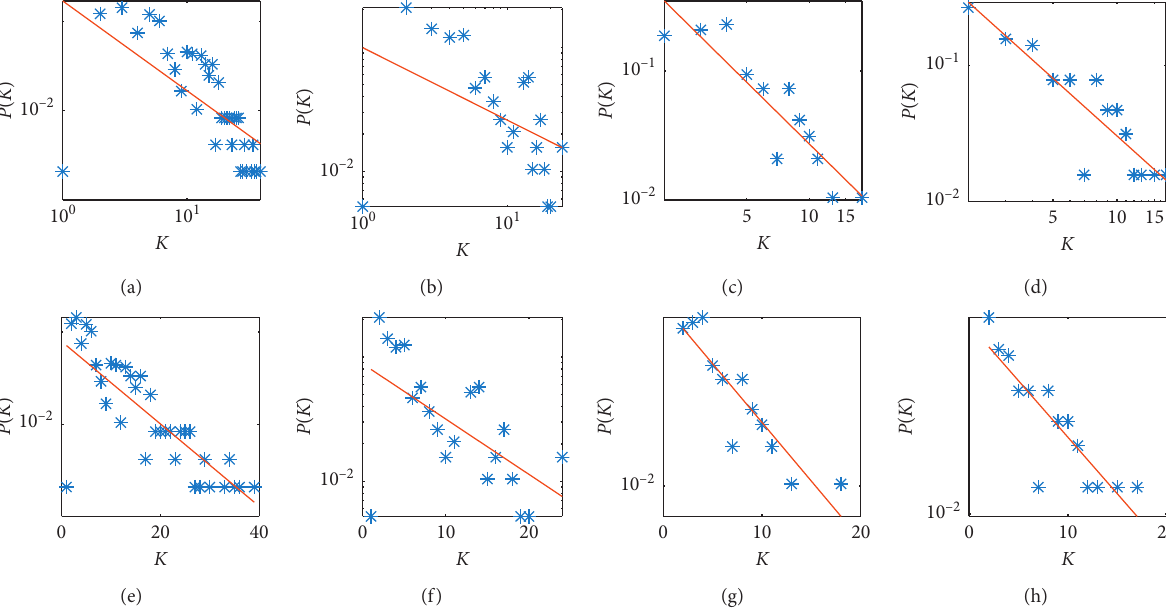
Figure 16: Results after power law distribution and exponential distribution fitting. (a) Δ t � 2 min. (b) Δ t � 5min. (c) Δ t � 10min. (d) Δ t � 15 min. (e) Δ t � 2min. (f) Δ t � 5min. (g) Δ t � 10min. (h) Δ t �